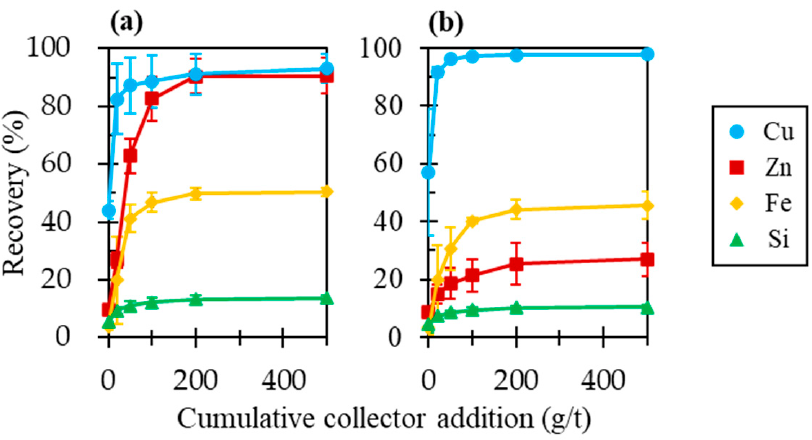
Figure 11. Flotation results of chalcopyrite, sphalerite, and pyrite in the presence of 1 kg/t zinc sulfate ( a ) with air and ( b ) with N 2 gas.